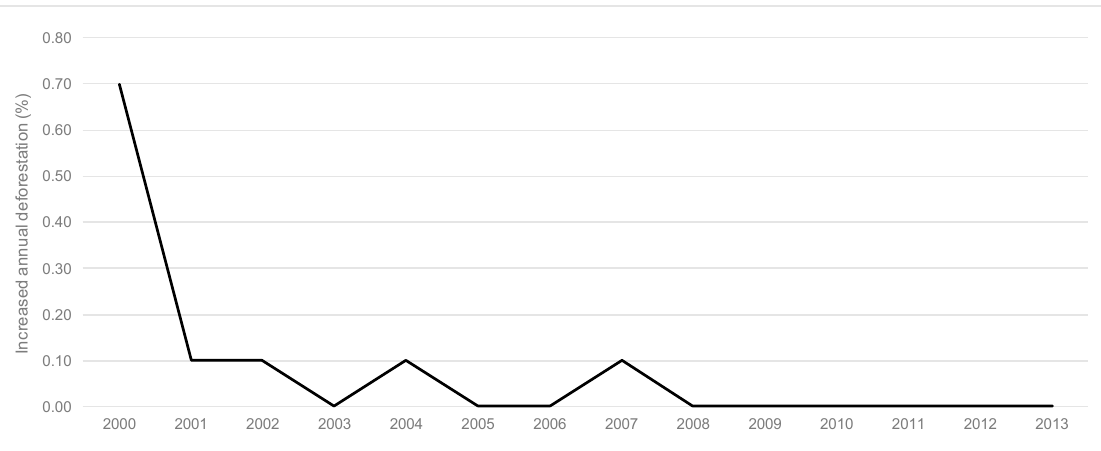
Figure 3. Products available at the store run by the cooperative in Santarém, the main municipality in western Pará state (Photos from Coomflona).